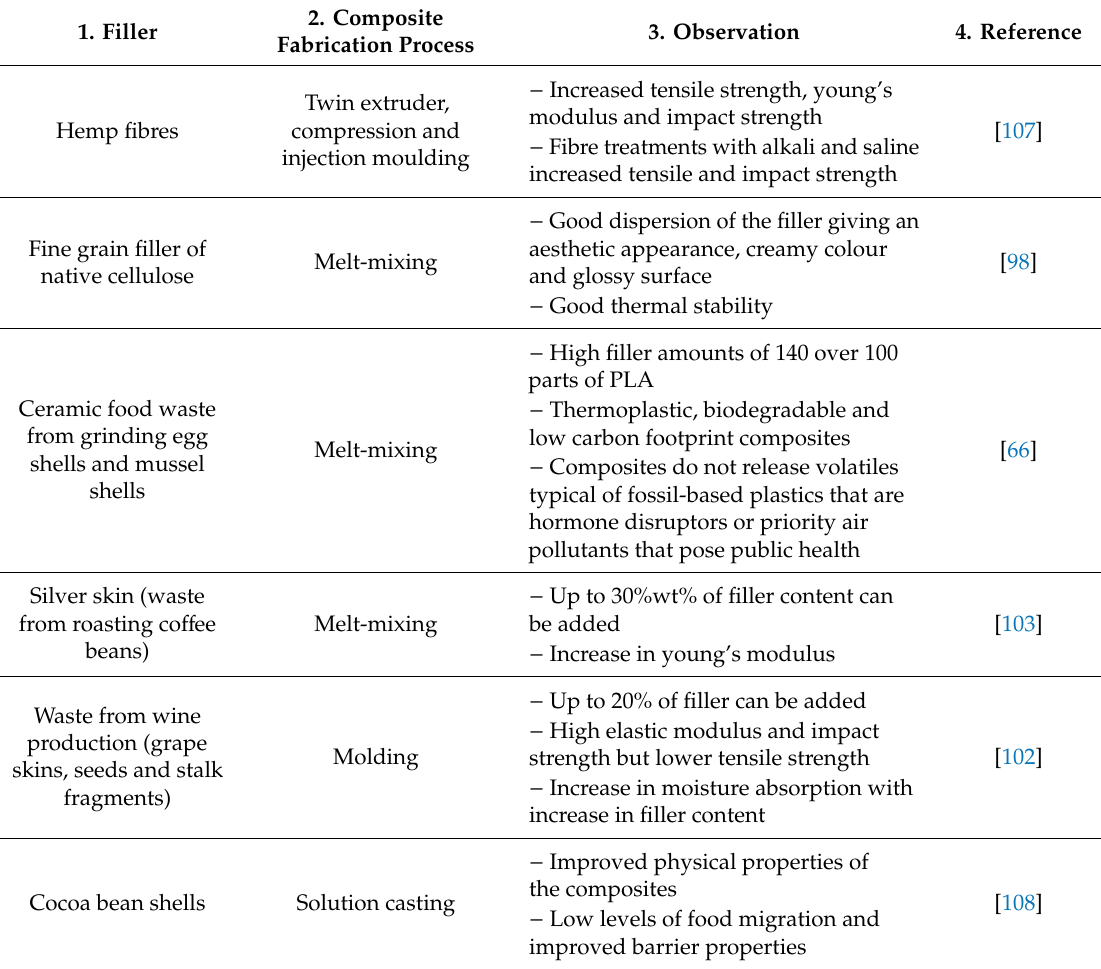
Table 1. Some PLA based